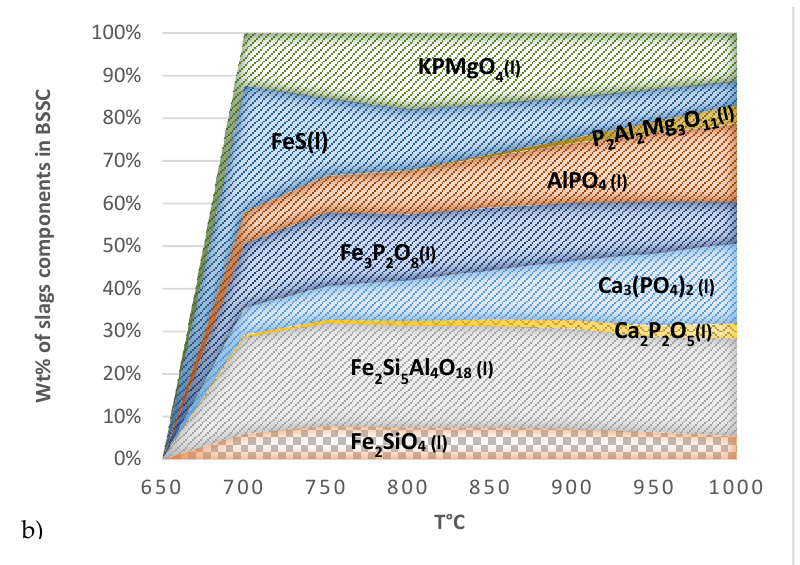
Figure 11 . The calculated equilibrium composition of slag compounds (liquid species) during the pyrolysis of sewage sludge at different temperatures: ( a ) LSSC and ( b ) BSSC.